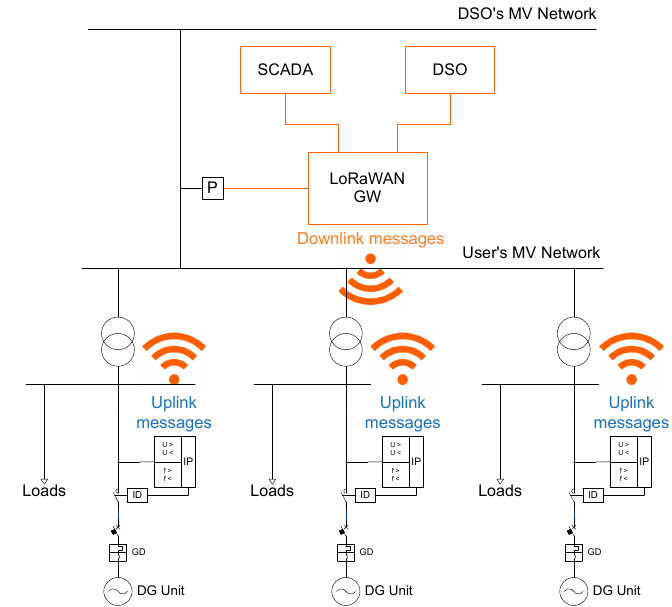
Figure 5. Schematic layout of a possible deployment of the proposed communication architecture. P: generic Protection (e.g., an IP implementing the 59N function or another independent protection).